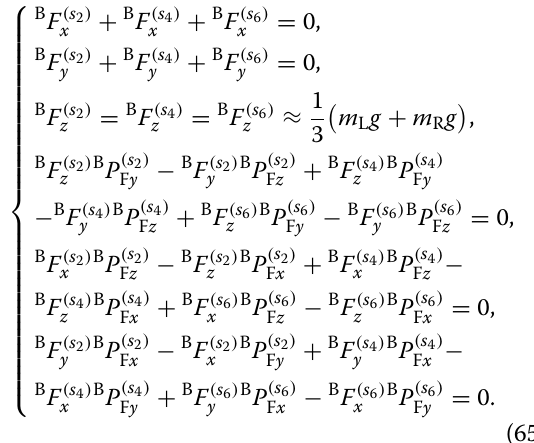
According to Eq. (65), the constraints of foot forces in the x direction can be written among the legs 2, 4, and 6.